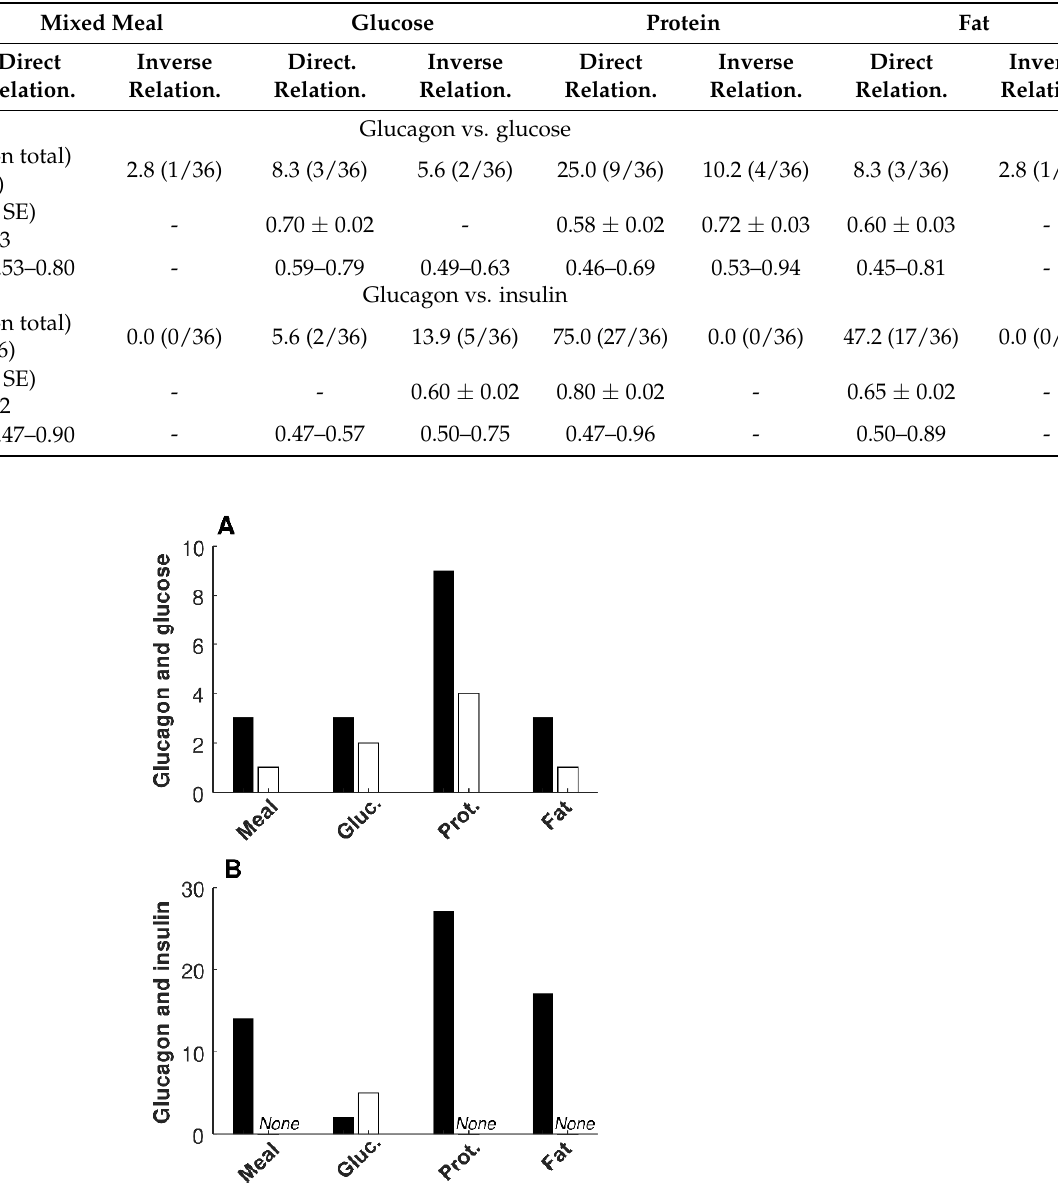
Figure 1. Number of cases showing significant direct regression (left bar, black) and inverse regression (right bar, white) between glucagon and glucose ( A ), and between glucagon and insulin ( B ), for different metabolic tests in individual regression analysis.